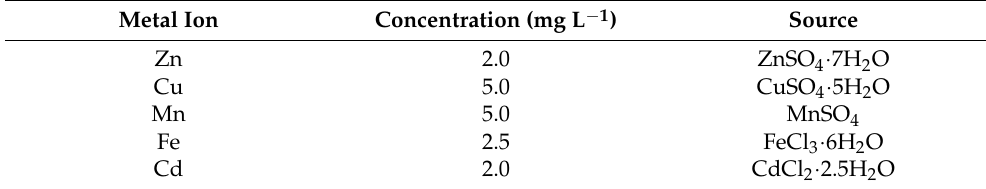
Table 2. Concentrations and sources of different metal ions used in this study.